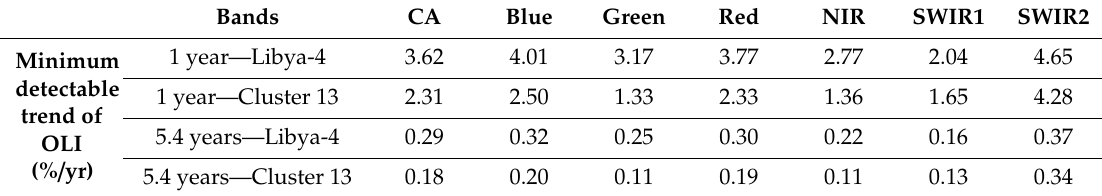
Table 8. Estimated minimum detectable trend comparison between EPICS and traditional PICS. Bands CA Blue Green Red NIR SWIR1 SWIR2